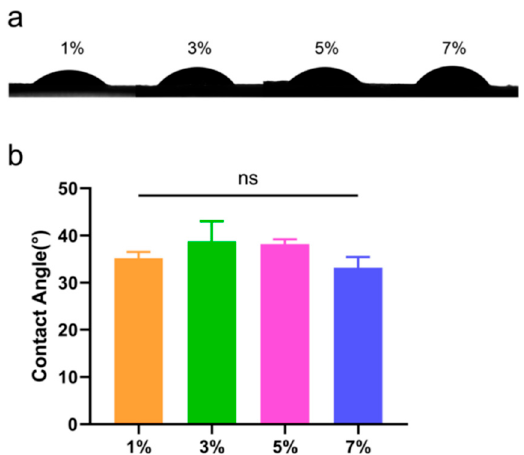
Figure 6. Hydrophilic analysis of different elastic chitosan lyophilized scaffolds. ( a ) Contact angle images of different elastic freeze-dried chitosan scaffolds; ( b ) Quantitative analysis of contact angles of different elastic freeze-dried chitosan scaffolds, n = 6, ns represents p > 0.05.